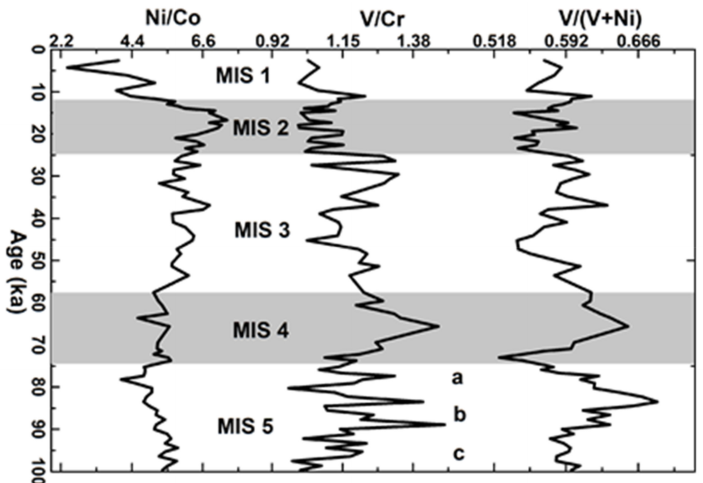
Figure 4. Down-core distribution of ratio of trace elements in the sediment core SK117/GC08 from eastern Arabian Sea during the past 100